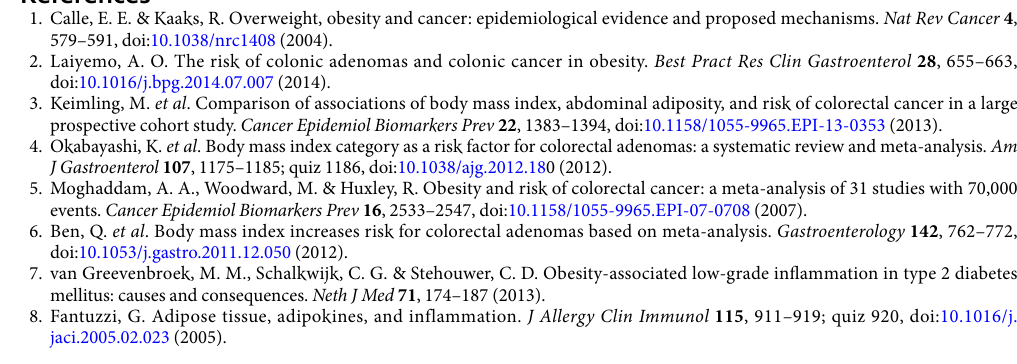
6 Scientific RepoRts | 7: 4456 | DOI:10.1038/s41598-017-04780-9